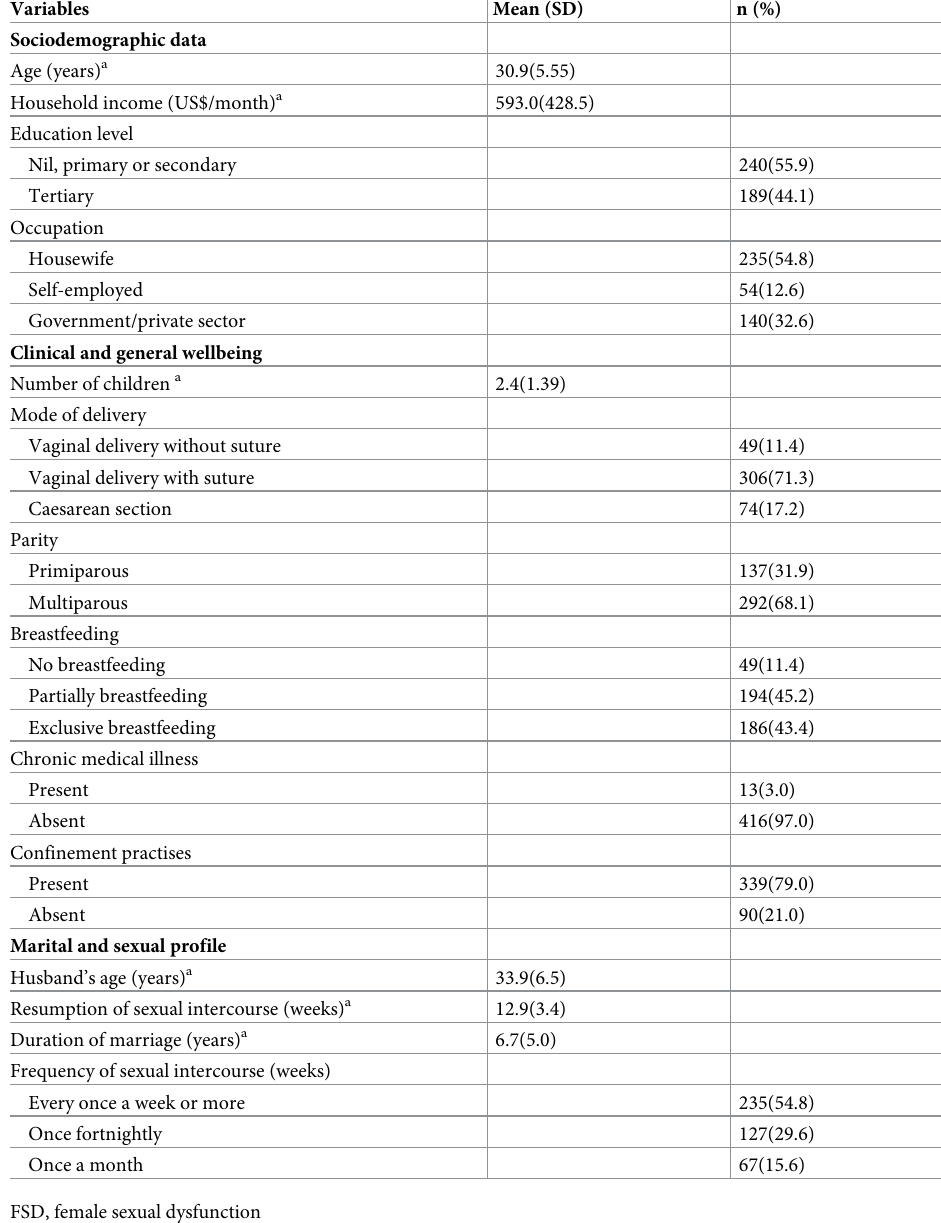
Table 1. Sociodemographic and clinical data of the participants (n =